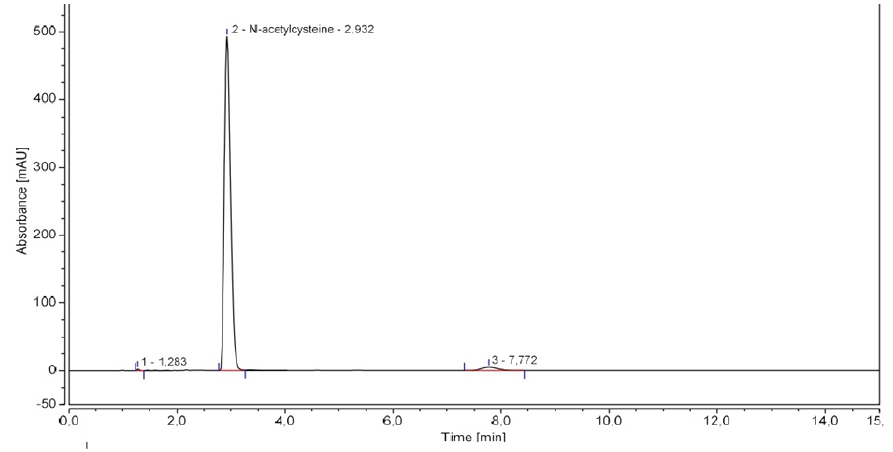
Figure 1. Representative NAC